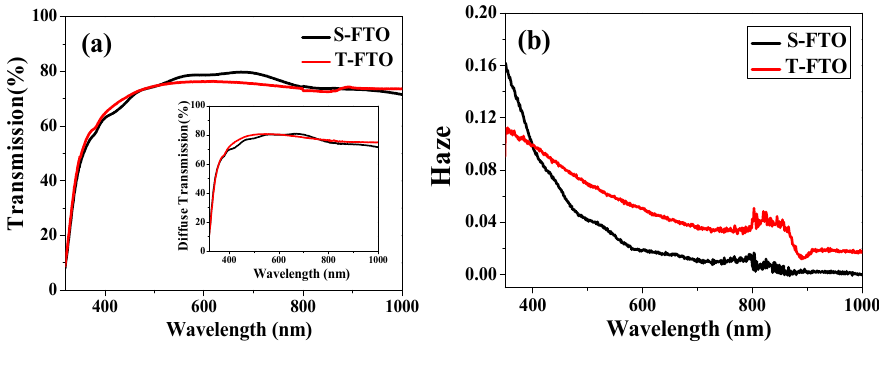
without Ag NPs concentration embedded in c-TiO 2 /m-TiO 2 / CH 3 NH 3 PbI 3 shows obvious